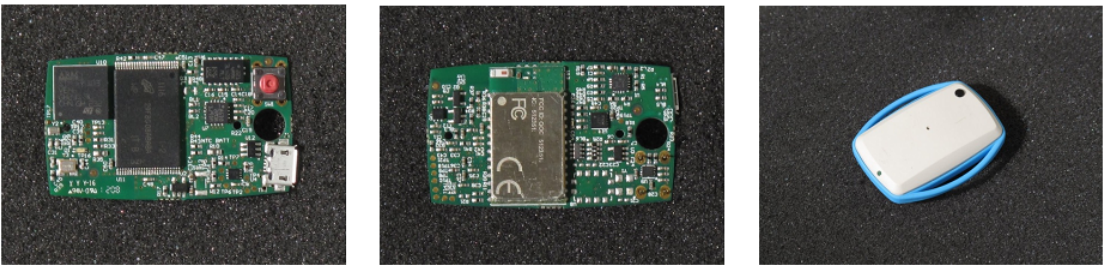
Figure 2. The EXLs1 sensing